Question: Which visualization type does this figure use?
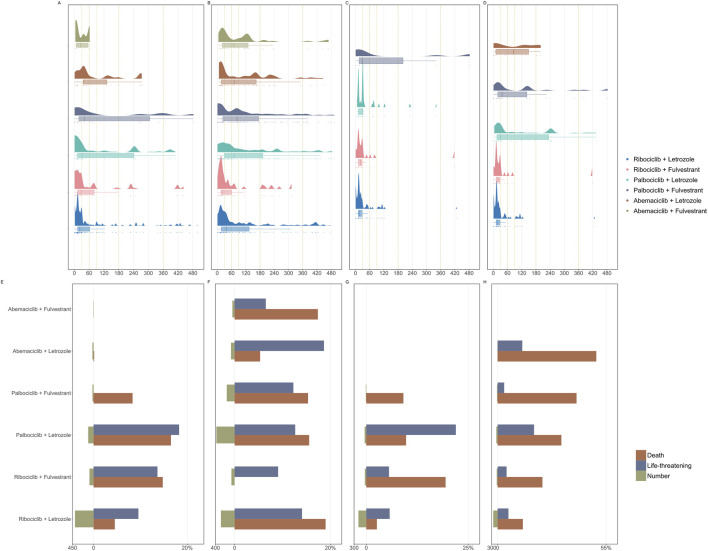
Answer: bar